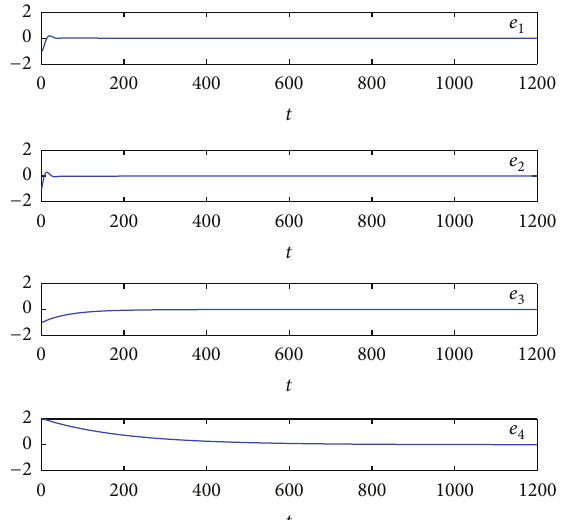
Figure 3: The MFPS errors between added-order system (31) and system